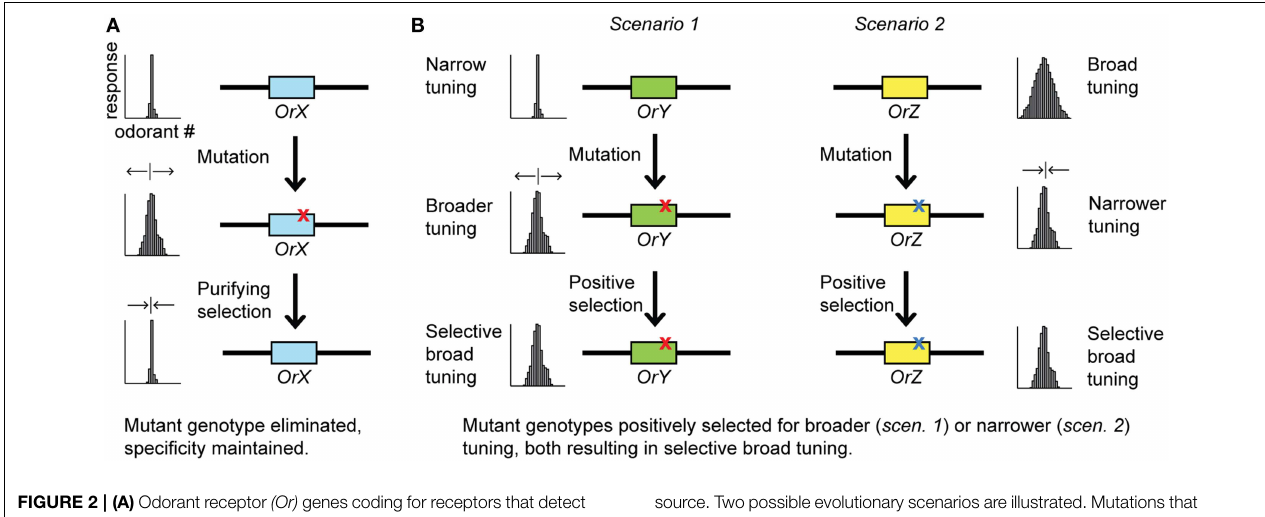
FIGURE 2 | (A) Odorant receptor (Or) genes coding for receptors that detect odorants important for fitness are generally under purifying selection and often narrowlytuned.Mutationstosuch Ors thatchangetheresponsespecificitywill typically be selected against and ultimately eliminated from the population. (B) Selection may favor “selective broad tuning” that allows an OR to detect multiple odorants, such as those emmanating from the same ecological